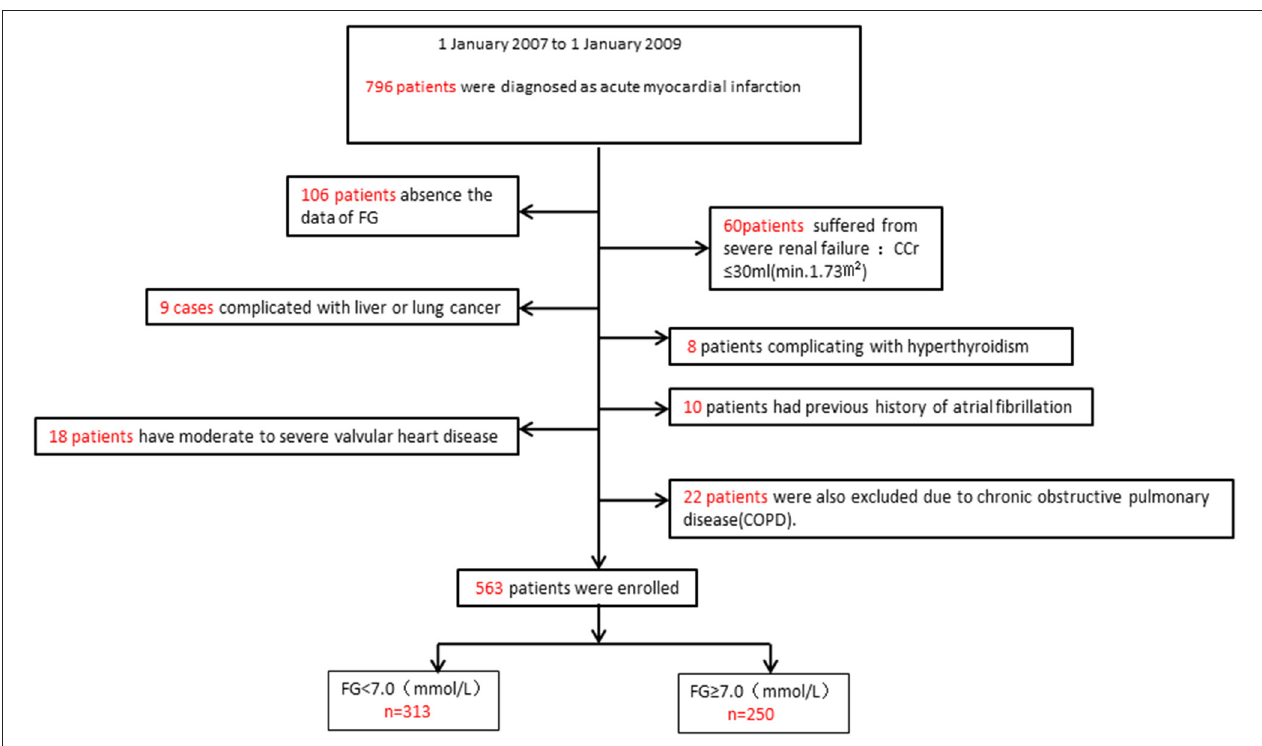
FIGURE 1 | Flow chart of participants. FG, fasting glucose; Ccr, creatinine clearance